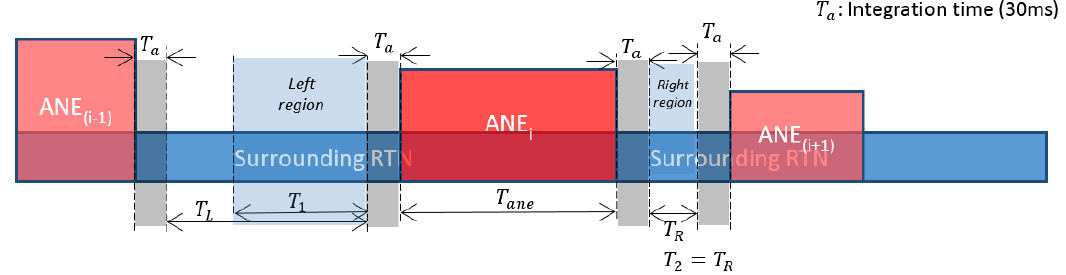
Figure 5. An anomalous noise event surrounded by road traffic or background noise. In this second case, left region contains more samples than right